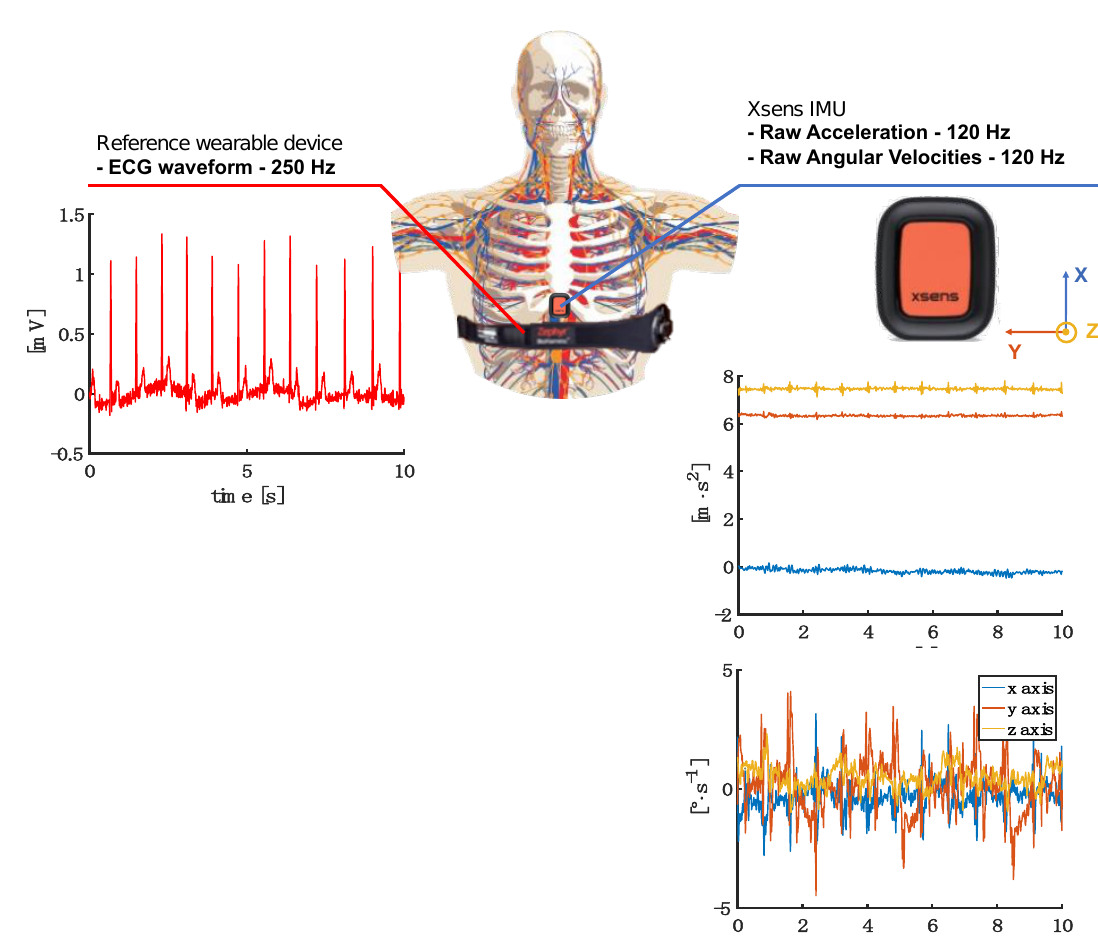
Figure 1. Schematic representation of the positioning of the sensors on the subject’s body and raw waveforms obtained from the ECG sensor sampled at 250 Hz (red waveform on the left) and the IMU sensor for both the accelerometer sensor and the gyroscope sampled at 120 Hz. For accelerometers and gyroscopes, all three axes are shown (x in blue, y in orange, and z in yellow). Regarding the IMU sensor, the x -axis is oriented from foot to head, the y -axis laterally from left to right, and the z -axis is oriented from back to chest.